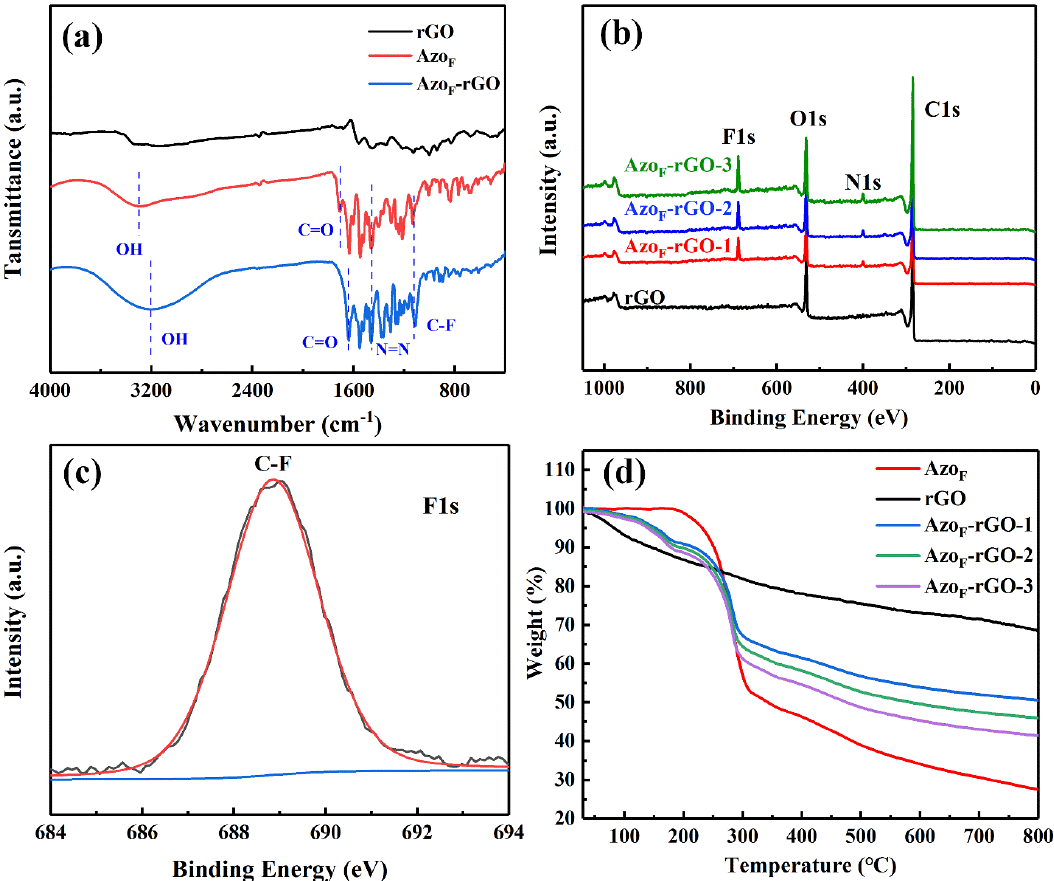
Figure 2. ( a ) FT-IR spectra of rGO, Azo F and Azo F -rGO. ( b ) XPS spectra of rGO and Azo F -rGO. ( c ) F1s XPS spectra of Azo F -rGO. ( d ) TGA spectra of rGO, Azo F and Azo F -rGO. Table 1. A d of Azo F on rGO.